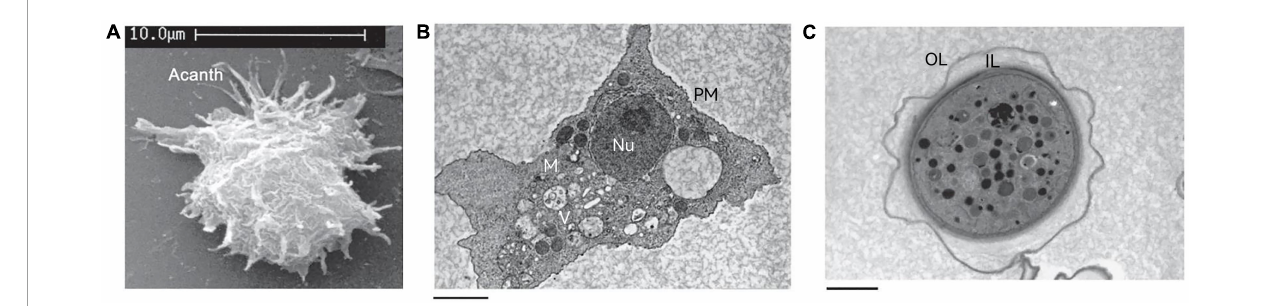
FIGURE2 The structure of Acanthamoeba . (A) Scanning electron micrograph of an Acanthamoeba trophozoite showing many spinous pseudopods around the whole surface of the cell. Acanth, acanthopod. (B) Transmission electron micrograph of the trophozoite stage of Acanthamoeba . Nu, nucleus; V, vacuoles; M, mitochondria; PM, plasma membrane. (C) Transmission electron micrograph of an Acanthamoeba cyst. OL, outer layer; IL, inner layer. These pictures are from the work of Siddiqui et al.